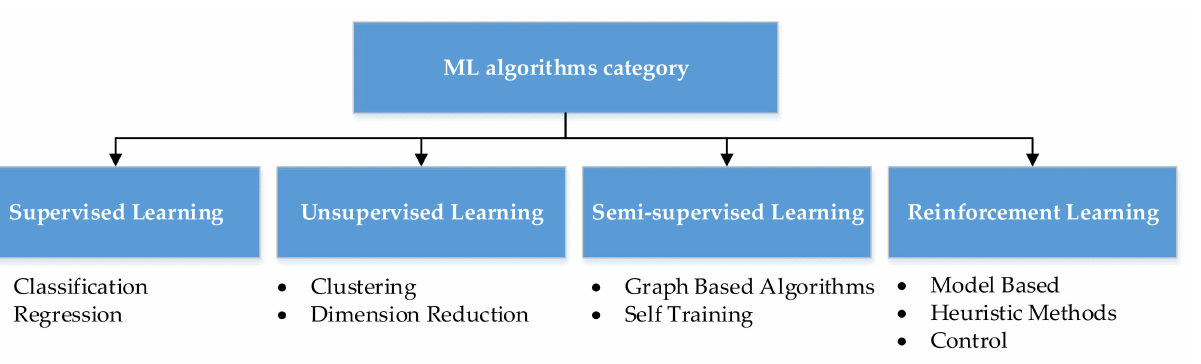
Figure 3. Illustration of ML